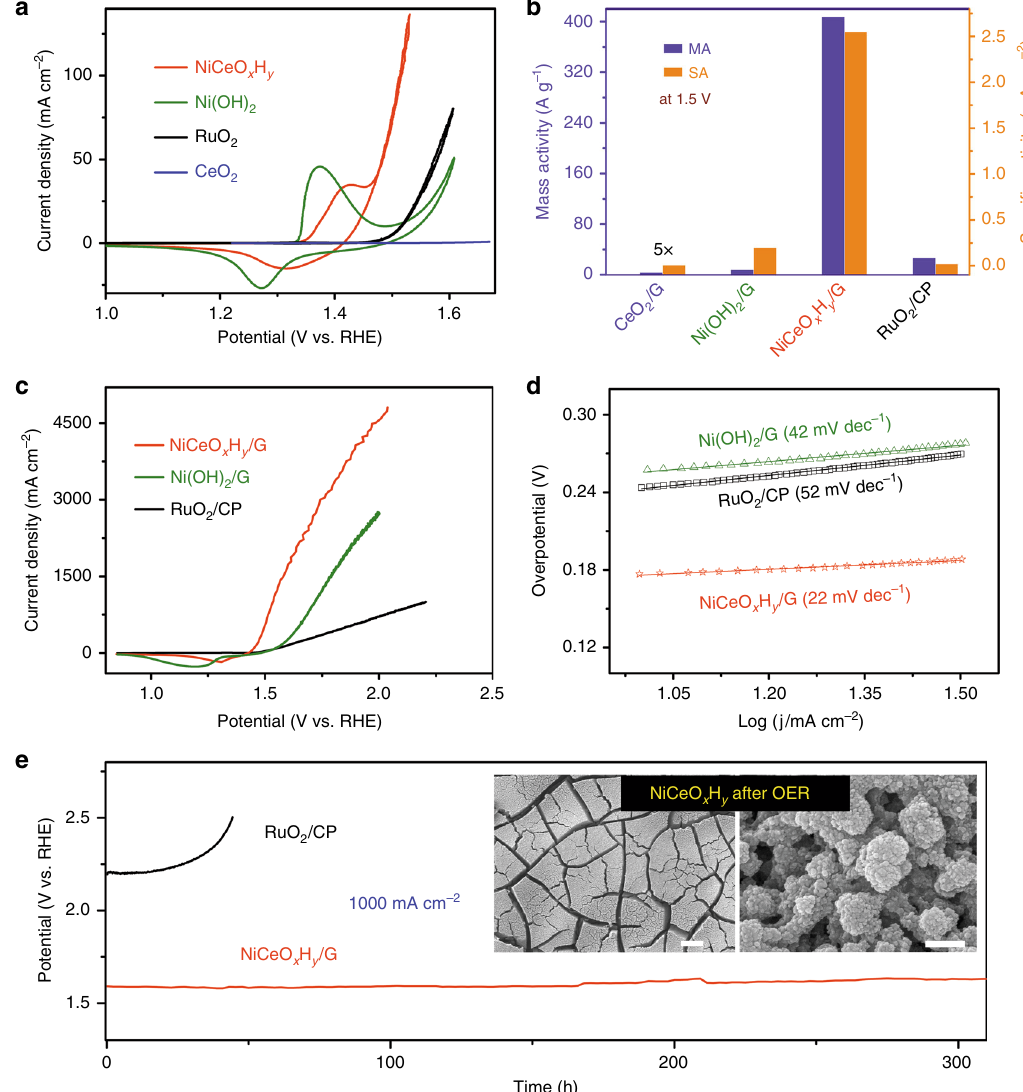
Fig. 5 Electrocatalytic OER performance in 1.0M KOH electrolyte. a Voltammetry (scan rate 10mVs − 1 ) of NiCeO x H y , Ni(OH) 2 , CeO 2 , and RuO 2 supported on rotational disk electrode with mass loading of 0.2mgcm − 2 . b Mass and speci fi c activities derived from ( a ) at 1.5V. The data of CeO 2 /G are multiplied by 5 for clear display. c Polarization curves (scan rate 10mVs − 1 ) of NiCeO x H y /G, Ni(OH) 2 /G, and RuO 2 /CP electrodes with mass loading of 10, 10, and 6mgcm − 2 , respectively. d Tafel plots derived from the curves in ( c ). e Chronopotentiometry of RuO 2 /CP and NiCeO x H y /G at a current density of 1000mAcm − 2 . Inset shows the SEM images (scale bar: left 20 μ m, right 200nm) of the NiCeO x H y /G electrode after OER test at 1000mAcm − 2 for